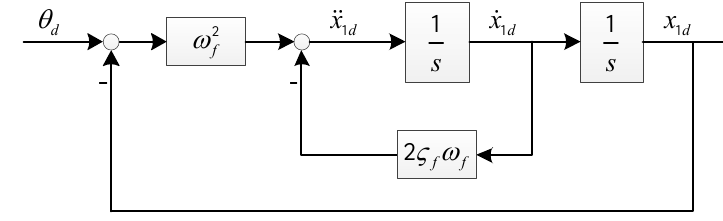
Figure 6. Command Figure 6. Command pre-filter.